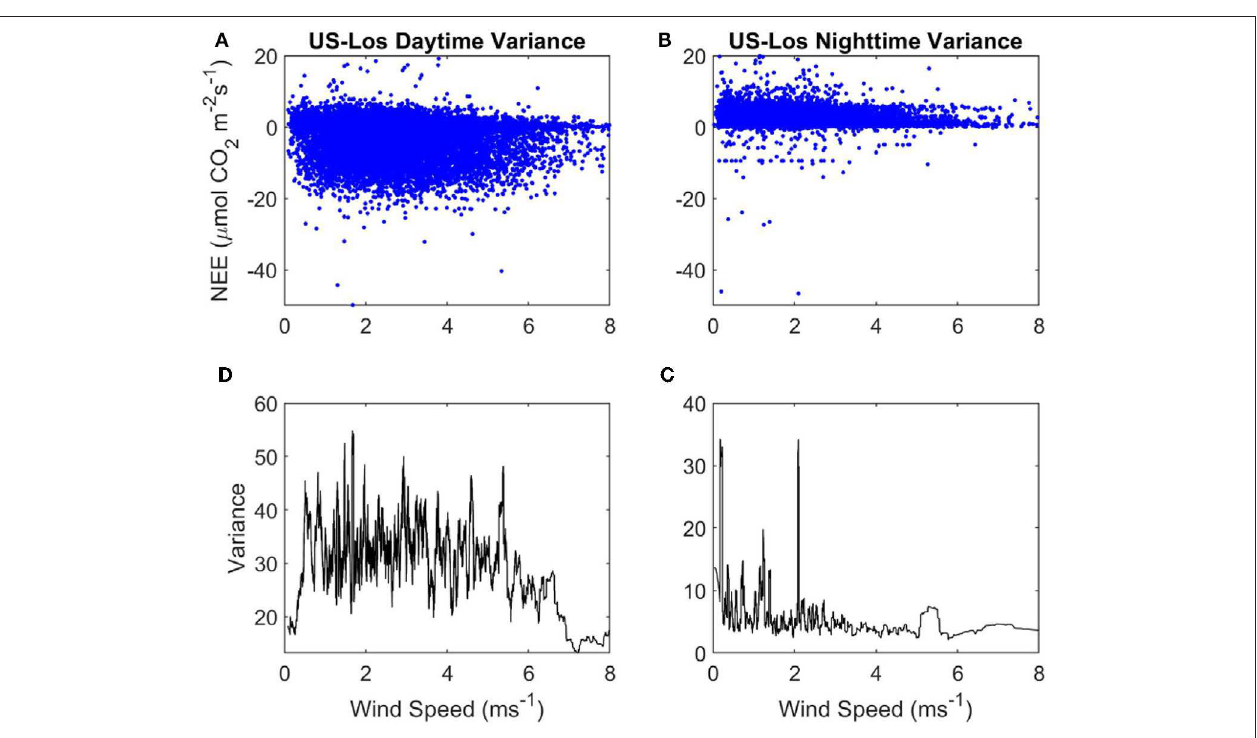
Frontiers in Environmental Science |